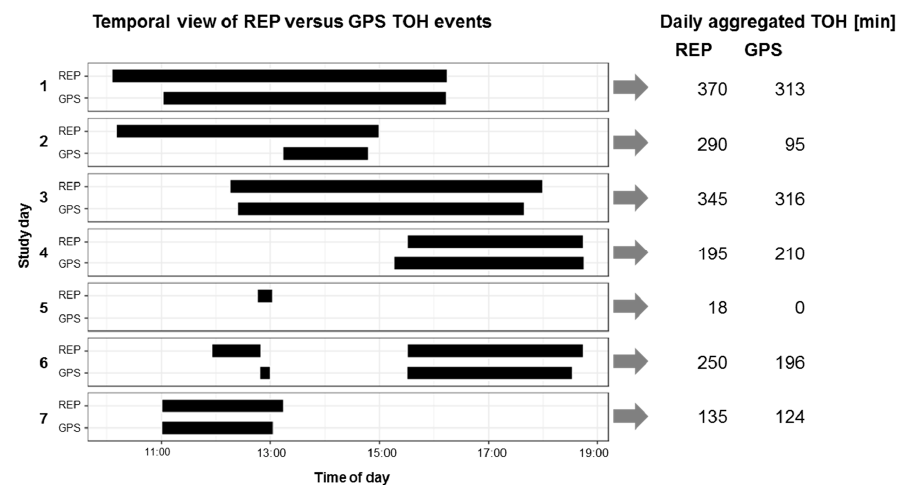
Figure 4. Daily temporal view of REP versus GPS TOH events ( left ) and daily aggregated indicators REP TOH versus GPS TOH ( right ) for one participant (one week).